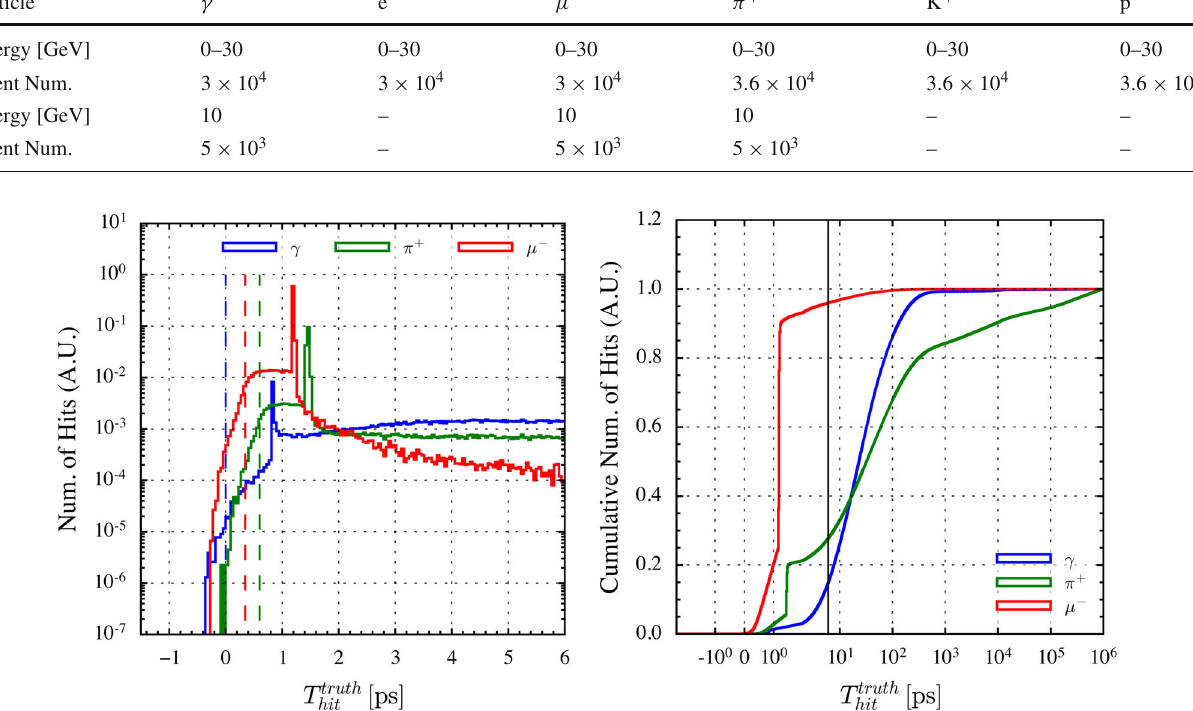
Fig. 4 The distribution of the true projected hit time in the range of < 6 ps in the 10 GeV γ , π + and μ − samples (left) and the correspond- ing cumulative distribution in the time range of 0 − 1 µ s (right). The dashed lines in the left plot are the expected time when the incident par- ticles reach the front of the ECAL. In the right plot, the solid black line correspondstotheboundary(6ps)oftheleftplot.Toshowthecomplete